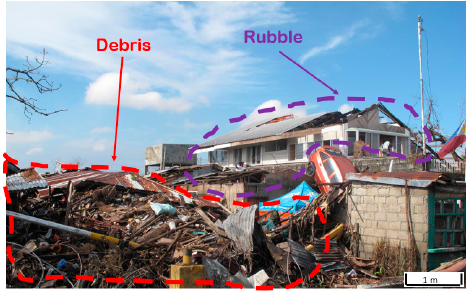
Figure 6. Damage classes: Examples of rubble and debris at the building level in Tacloban [32]. Remote Sens. 2019 , 10 , x FOR PEER REVIEW